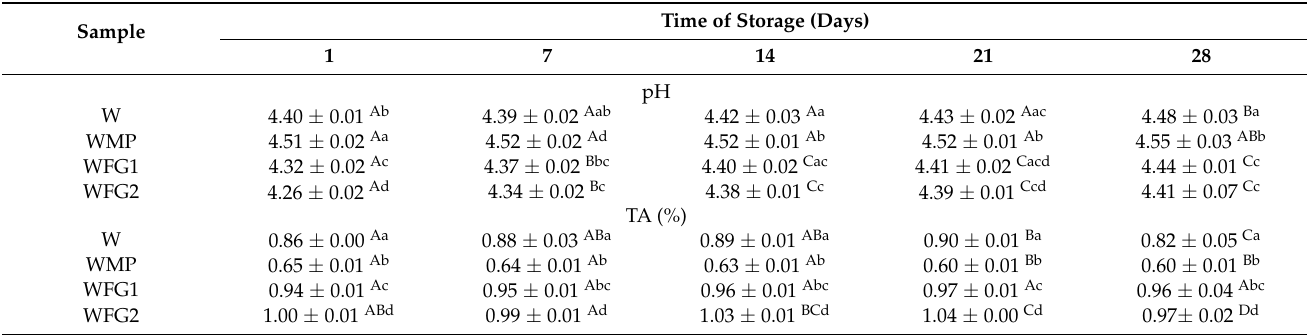
Table 2. pH and titratable acidity of the samples during storage